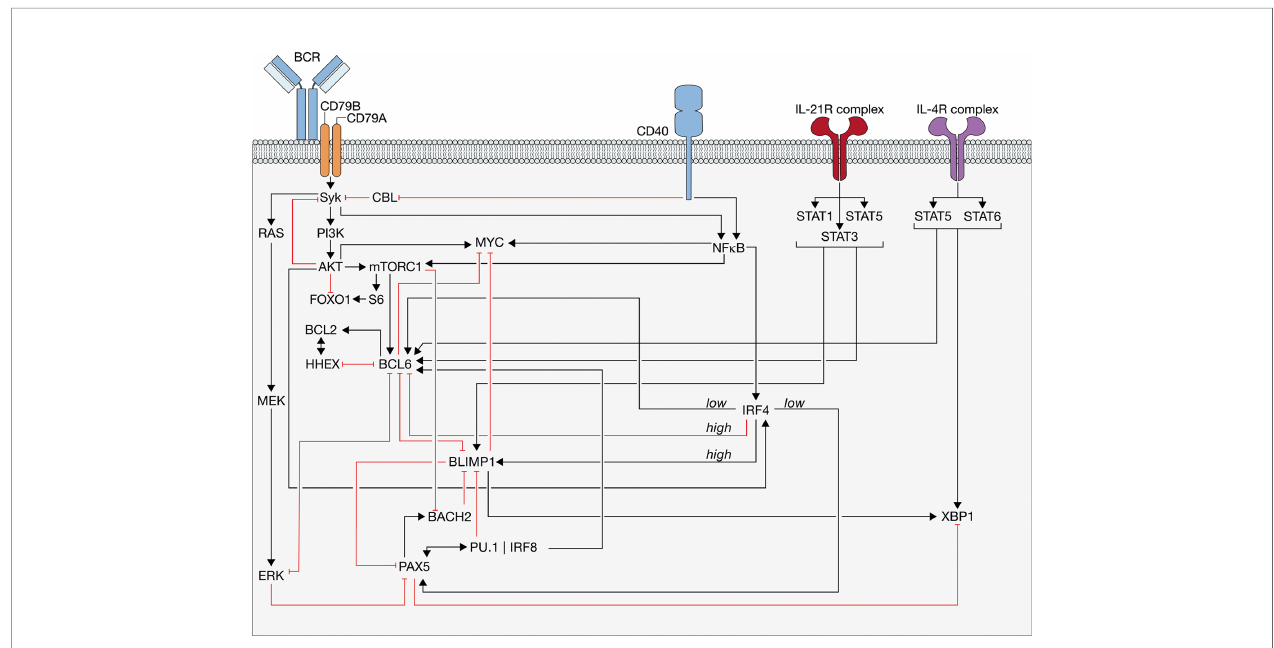
FIGURE 5 | Control of the germinal center (GC) and differentiation mediated through receptor stimulation. The regulation of GC continuation and differentiation mediated through the different receptors-mediated signal transductions is shown. Activations (black lines with an arrow head) and inhibitions (red lines with a fl attened head) among genes and some proteins are shown. Relevant ones are: BTB and CNC homologue 2 (BACH2), B cell lymphoma 2 (BCL2), BCL6, B cell receptor (BCR), B lymphocyte-induced maturation protein-1 (BLIMP1), cluster of differentiation 40 (CD40), Extracellular signal-regulated kinases (ERK), Forkhead box protein O1 (FOXO1), Haematopoietically-expressed homeobox (HHEX), Interleukins 4 receptor (IL-4R), IL-21R, Interferon-regulator factor 4 (IRF4), IRF8, mammalian target of rapamycin complex 1 (mTORC1), Paired box protein 5 (PAX5), Phosphoinositide 3-kinases (PI3K), signal transducer and activator of transcription (STAT) and X-box-binding protein 1 (XBP1) (see text for